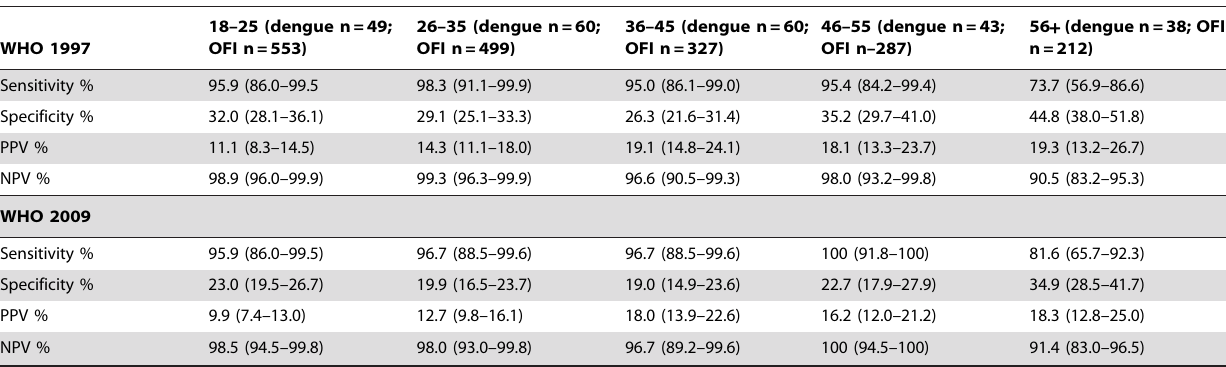
Table 8. Age-specific features of probable dengue diagnosis using the WHO 1997 or 2009 classification schemes.